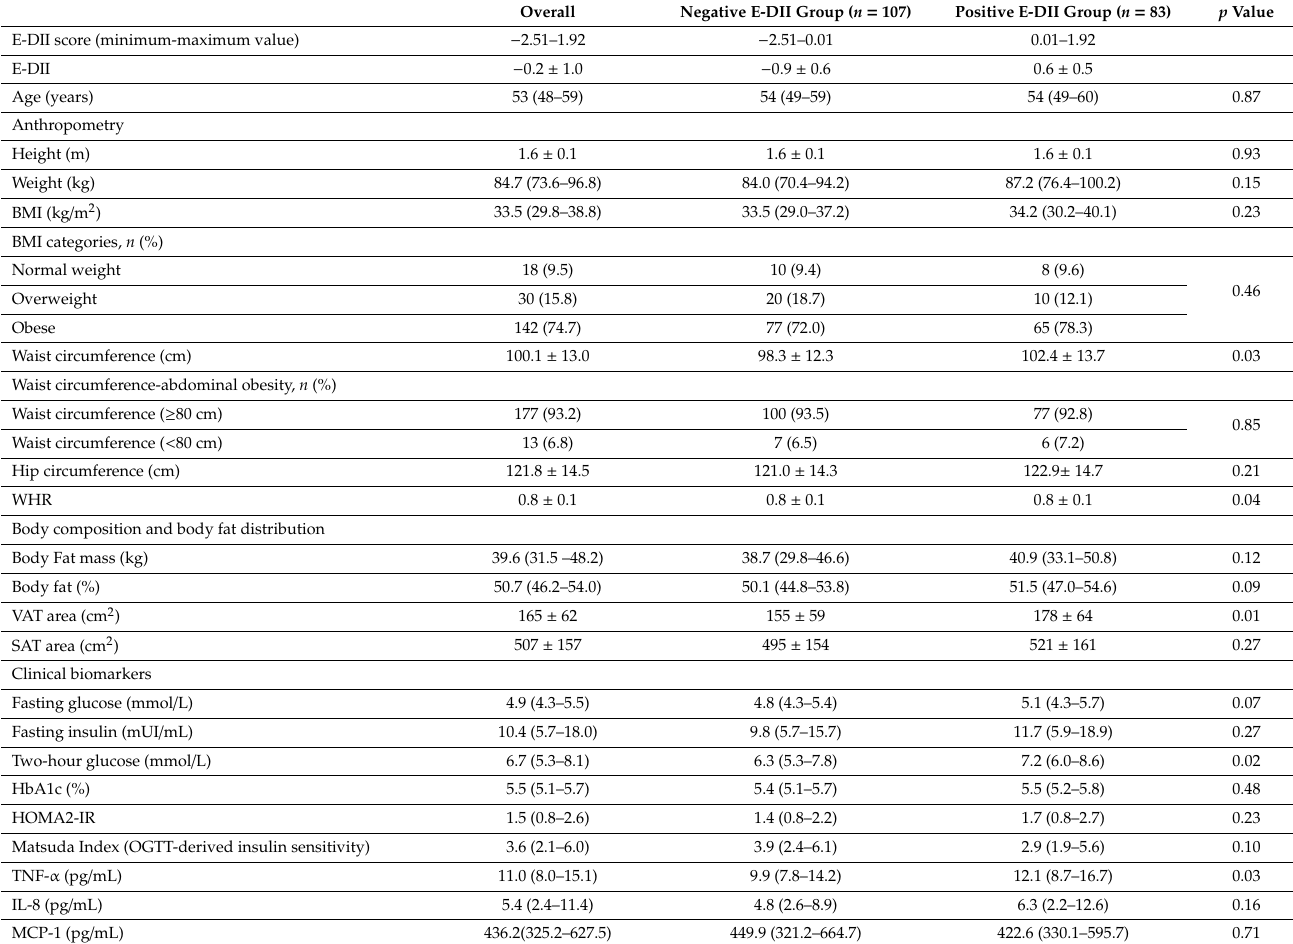
Table 1. Body composition and clinical characteristics of the participants according to E-DII